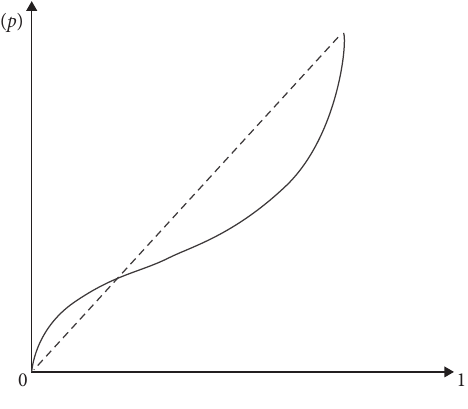
Figure 2: Decision weight function π ( p ) .